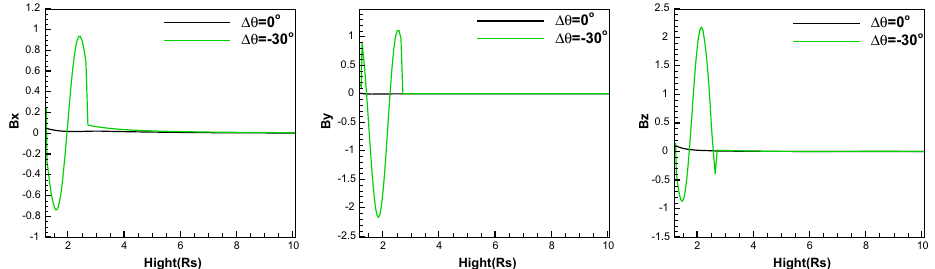
Fig. 12. Evolution of the three components of magnetic fi eld along heliocentric distance with different latitudes at t = 0. The columns from left to right are B x , B y and B z in GSE coordinates, respectively.